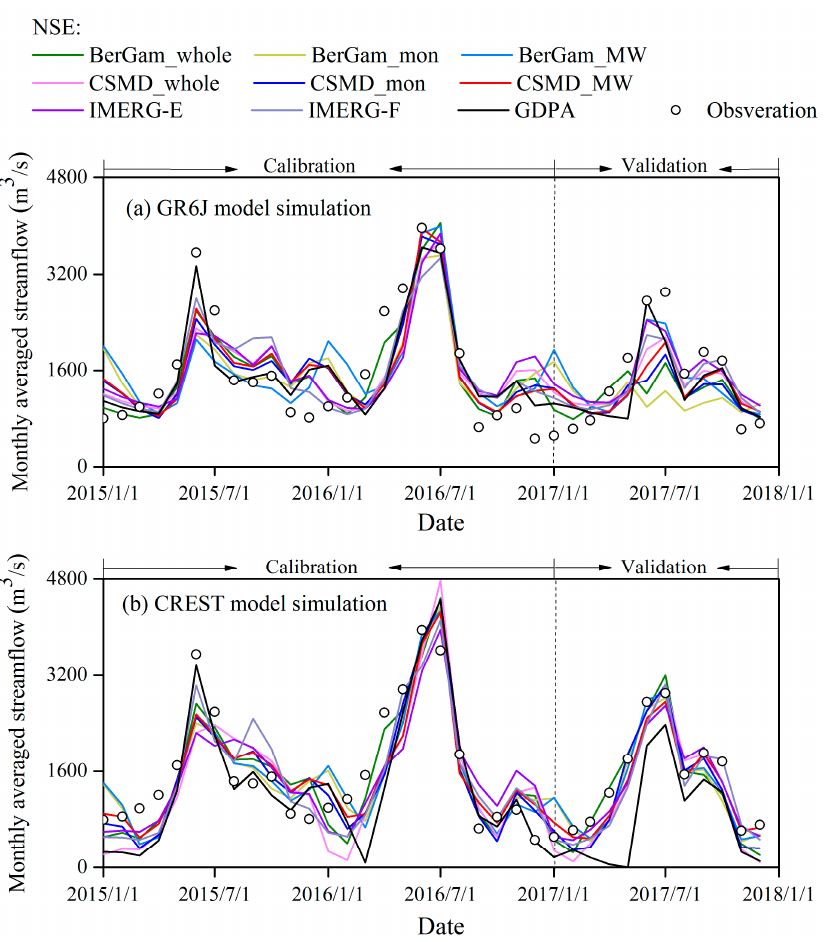
Figure 12. Performance of hydrological effect of bias-corrected satellite precipitation estimates IMERG-E, detected by streamflow simulated via lumped GR6J and distributed CREST models at the Wulong outlet of the Wujiang catchment. Table 3. Performance of streamflow simulation driven by the raw IMERG-E, bias-corrected IMERG-E, post-real-time IMERG-F and ground reference